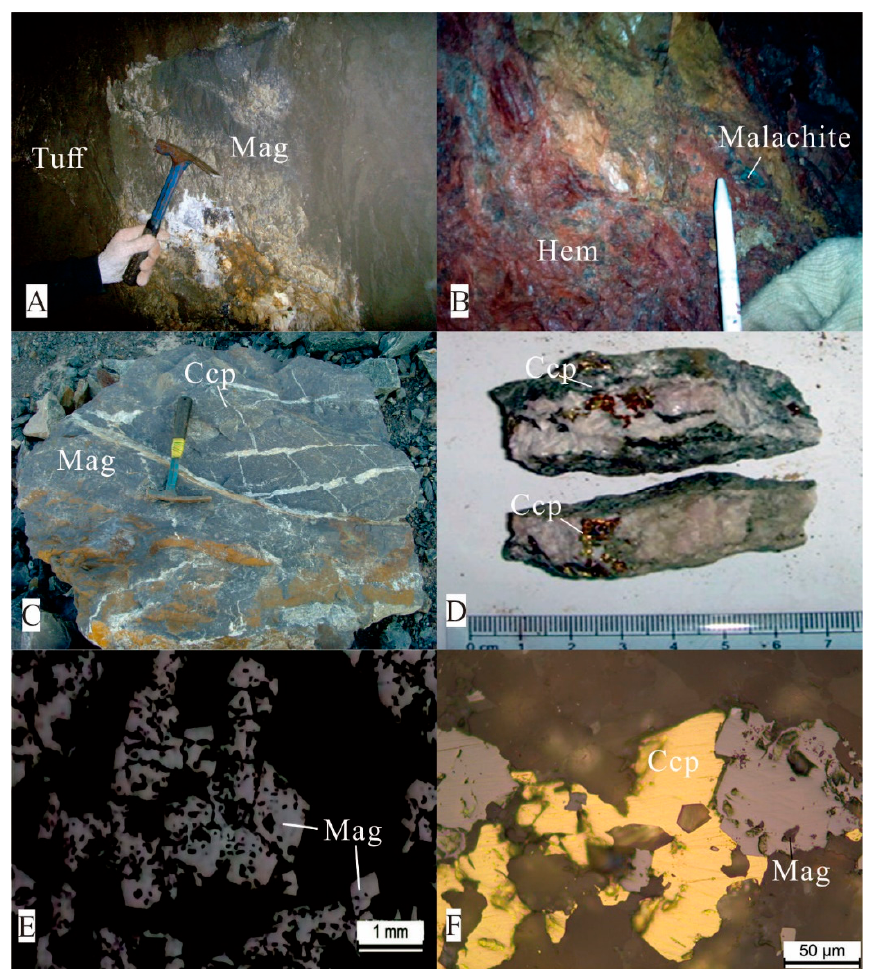
Figure 6. Photos and microphotographs of the Fe-Cu ores at Xianglushan. ( A ) Massive magnetite ores in contact with tuff (Xianglushan ore section); ( B ) supergene hematite–malachite ores in spilite (Yaopengzi ore section); ( C ) disseminated chalcopyrite in massive magnetite ores, crosscut by quartz veins; ( D ) quartz-chalcopyrite ore veins; ( E ) massive euhedral–subhedral magnetite; ( F ) magnetite included in chalcopyrite. Abbreviations: Mag—Magnetite; Hem—Hematite; Ccp—Chalcopyrite.